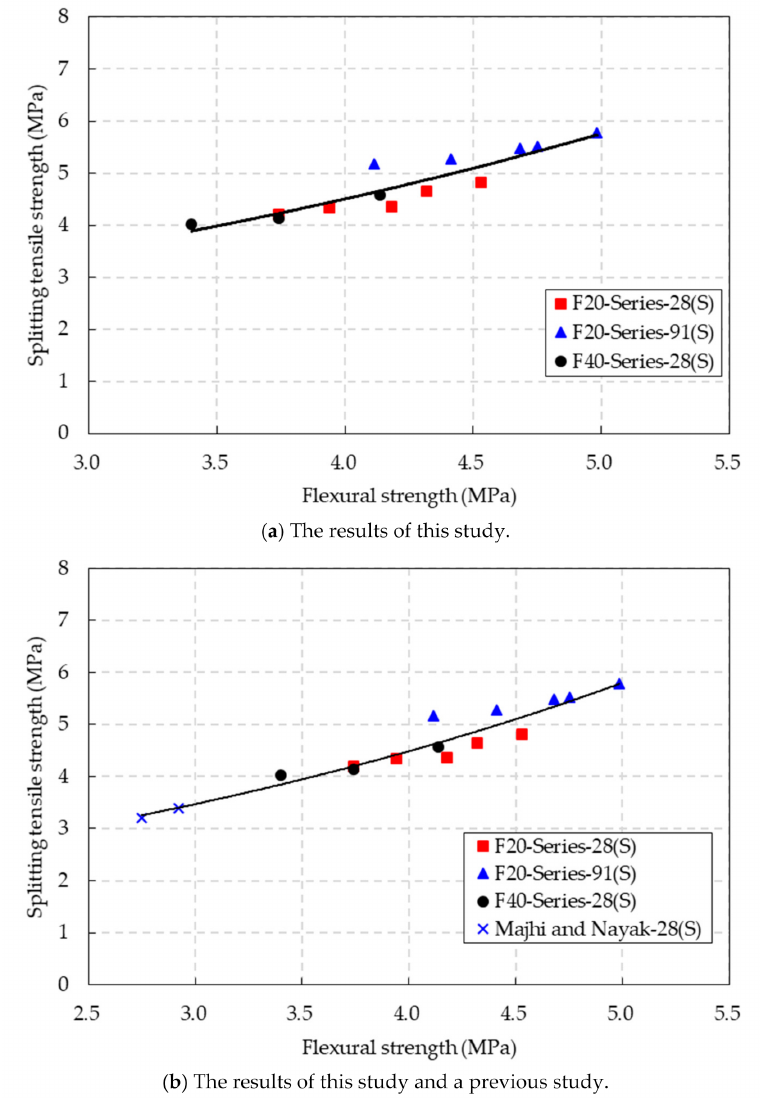
Figure 13. Relationship between the splitting tensile strength and flexural strength of the CBA